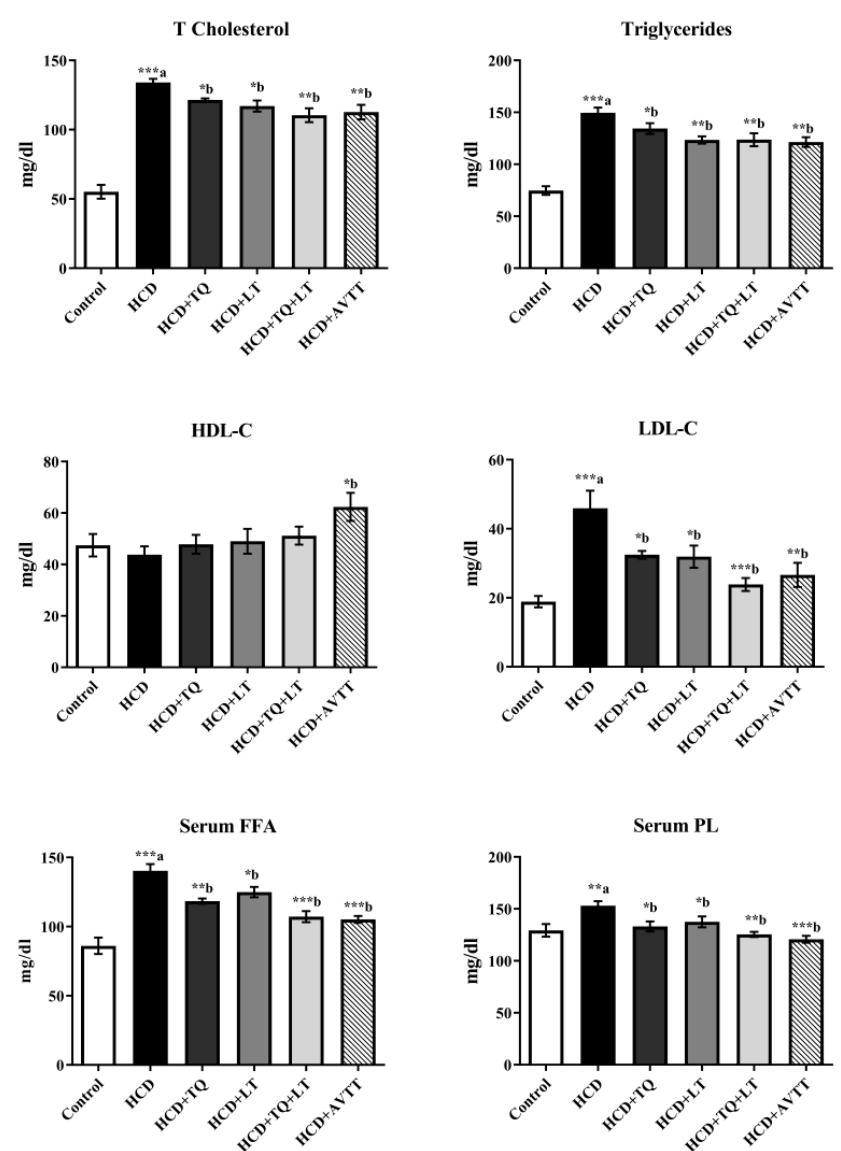
Figure 3. Effects of thymoquinone (TQ), losartan (LT) and their combination on high-cholesterol diet (HCD)-induced changes in serum levels of total cholesterol (TC), triglyceride (TG), high-density lipoprotein cholesterol (HDL-C), low-density lipoprotein cholesterol (LDL-C), free fatty acids (FFA) and phospholipids(PL). Data are expressed as Mean ± SE (n = 6) and analyzed using one-way ANOVA followed by Student–Newman–Keuls as post hoc test. a Control vs. HCD group; b HCD vs. QT or LT or QT + LT. p values considered significant when * p < 0.05, ** p < 0.01 and *** p < 0.001.